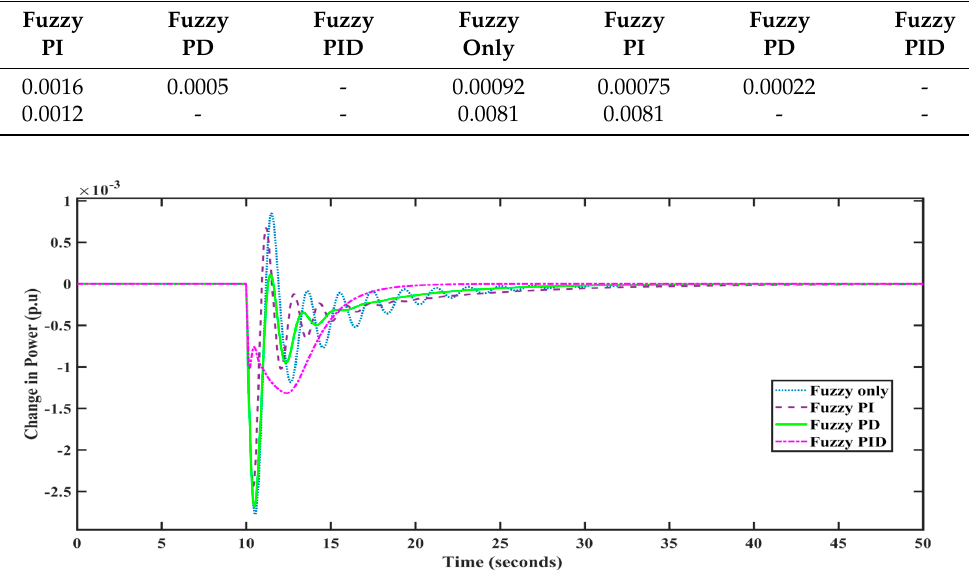
Figure 12. Dynamic response comparison of different control configurations of IHPS power change with step input of 1% increase in load.